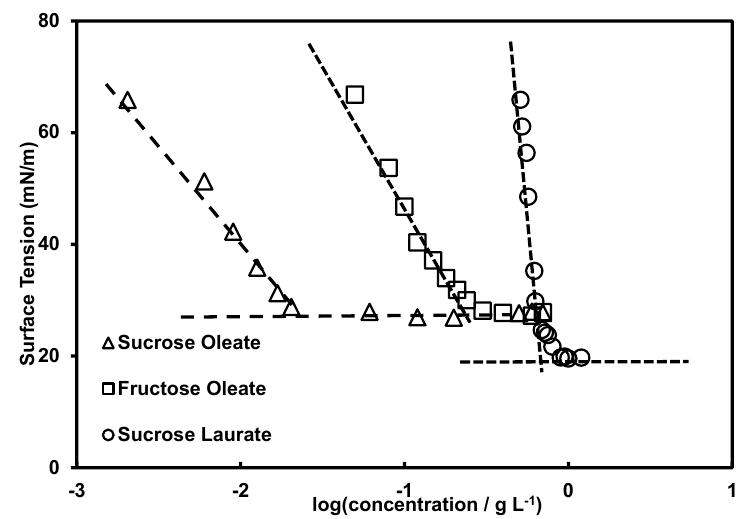
Figure 2. Surface tension ( γ ) at 22 °C vs. concentration ( C ) for sugar esters: sucrose oleate ( ∆ ), fructose oleate ( □ ), and sucrose laurate ( ○ ).Intersection of the dashed lines represent determination of the critical micellar concentration (CMC).